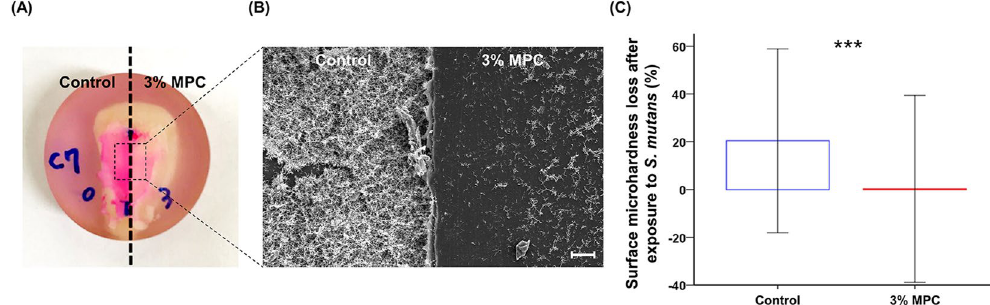
Figure 5. Representative photograph of a bovine tooth to which control and 3% MPC-LCFV was applied on each side and that was exposed to BHI culture medium supplemented with 2% sucrose and bacterial inoculum. Trace Disclosing Solution was applied to the sample ( A ). Representative scanning electron image of bacteria attached on the surfaces of the control and 3% MPC-LCFV at a magnification of 100 × ( B ). Scale bar is 40 µ m. Comparison of enamel surface microhardness loss (%) after exposure to a bacterial culture between the control and 3% MPC-LCFV ( C ). *** P < 0.001 for comparisons between the control and 3% MPC-LCFV before and after exposure a bacterial